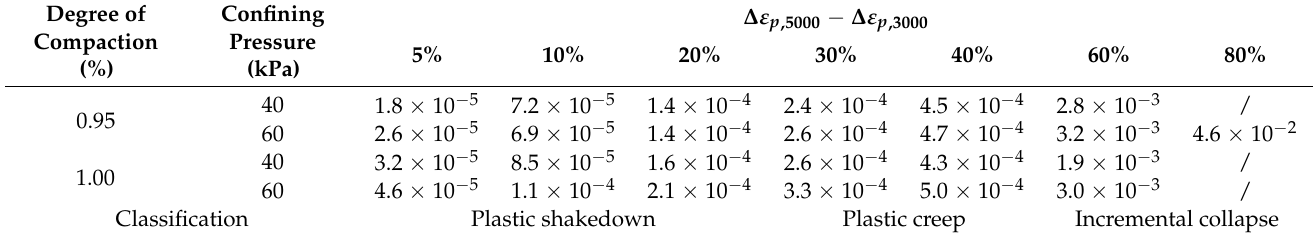
Table 2. Classification of the deformation properties for the investigated samples on the basis of ∆ ε ∆ ε p ,5000 − p ,3000